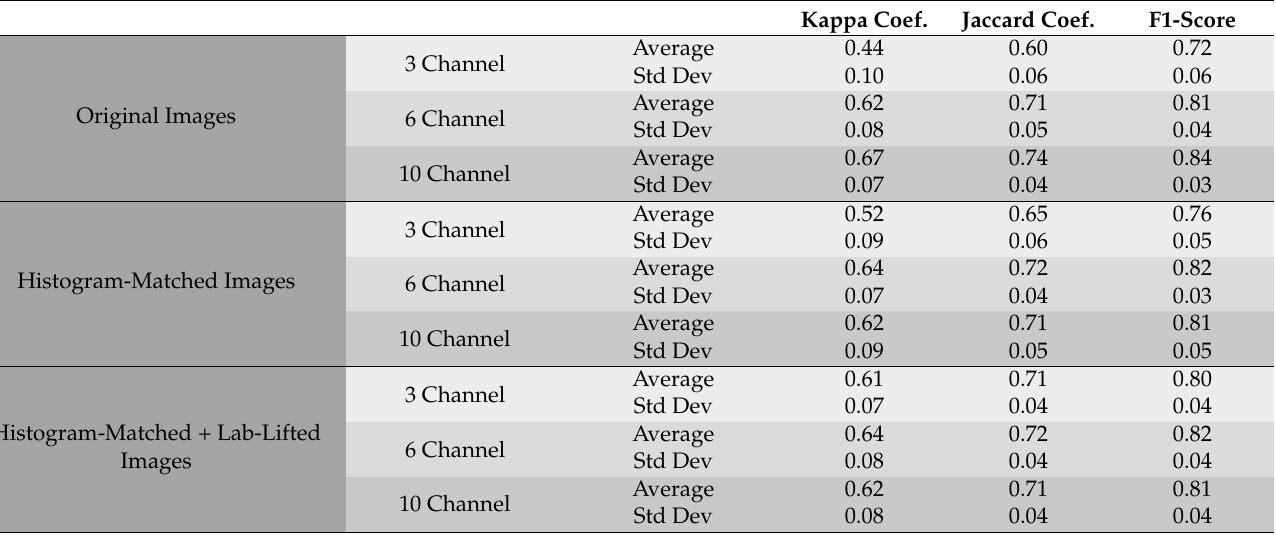
Table A7. Binary Change detection results for the SVM-STV method. Different channels results represented with